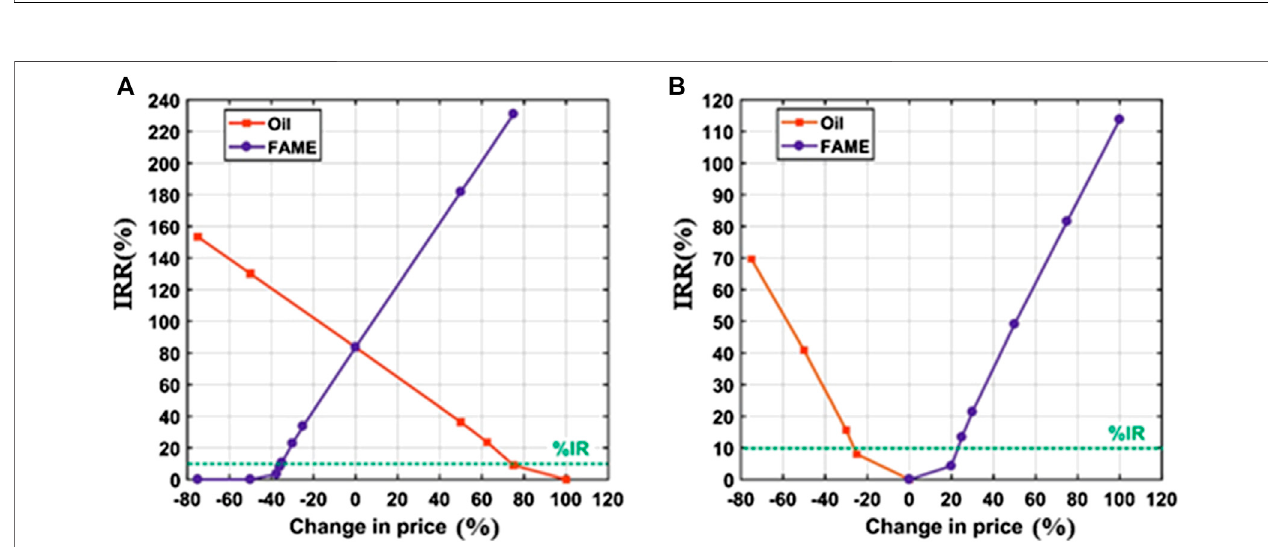
Figure 6 | IRR (%) sensitivity to the change of market prices of oil and FAME for the (A) homogeneous process and (B) heterogeneous process. The dotted green lines represent the IR.